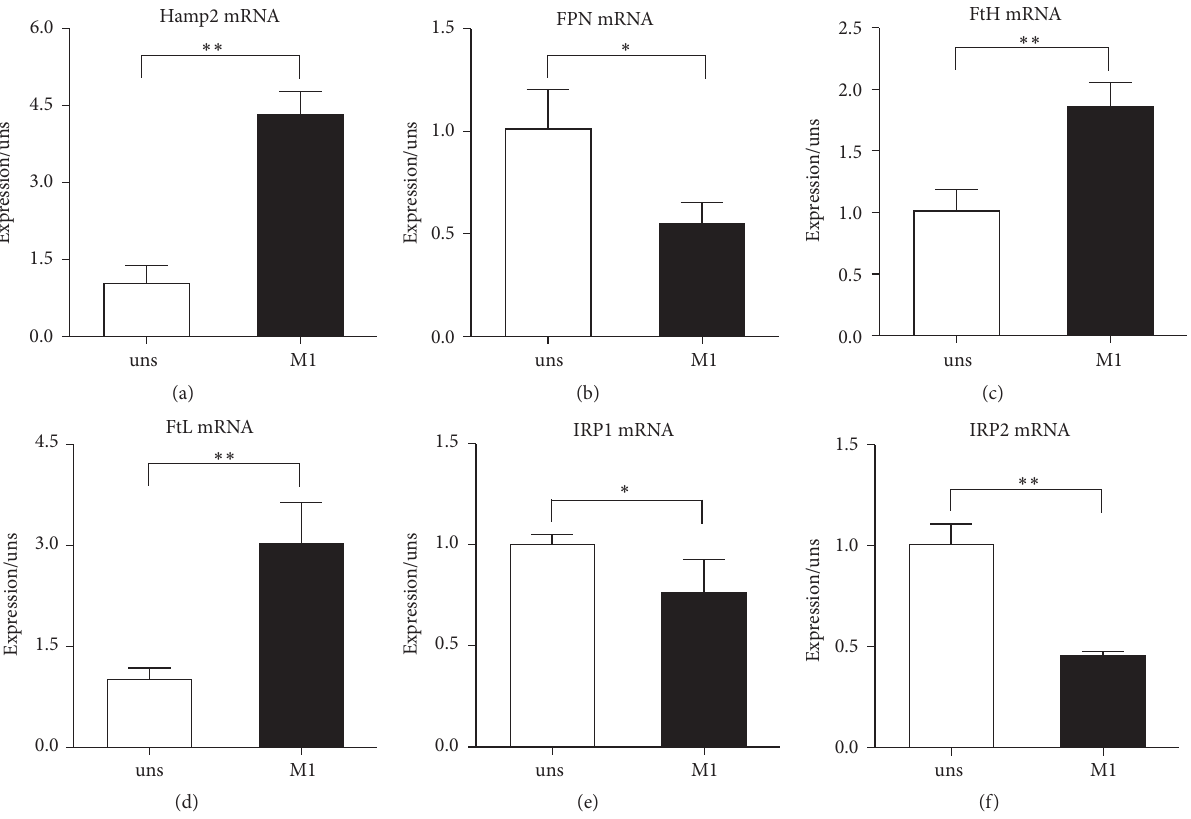
Figure 1: Differential expression of iron metabolism-related genes in M1 macrophages. (a) Hamp2, (b) FPN, (c) FtH, (d) FtL, (e) IRP1, and (f) IRP2 mRNA levels in 24 h cells after polarization. The expression was normalized to 𝛽 -actin and then expressed in relation to unstimulated macrophages, arbitrarily defined as 1. Data are mean ± SD for three independent experiments. (uns: unstimulated macrophages; ∗ 𝑝 < 0.05 , ∗∗ 𝑝 < 0.01